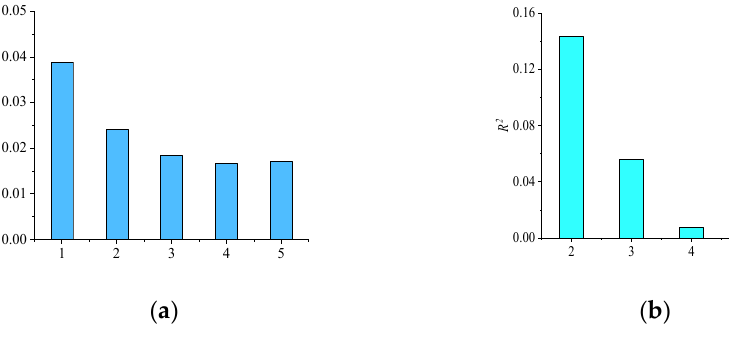
Figure 3. Grid independence validation . ( a ) V u ; ( b ) R 2 . Table 3. Grid independence validation.